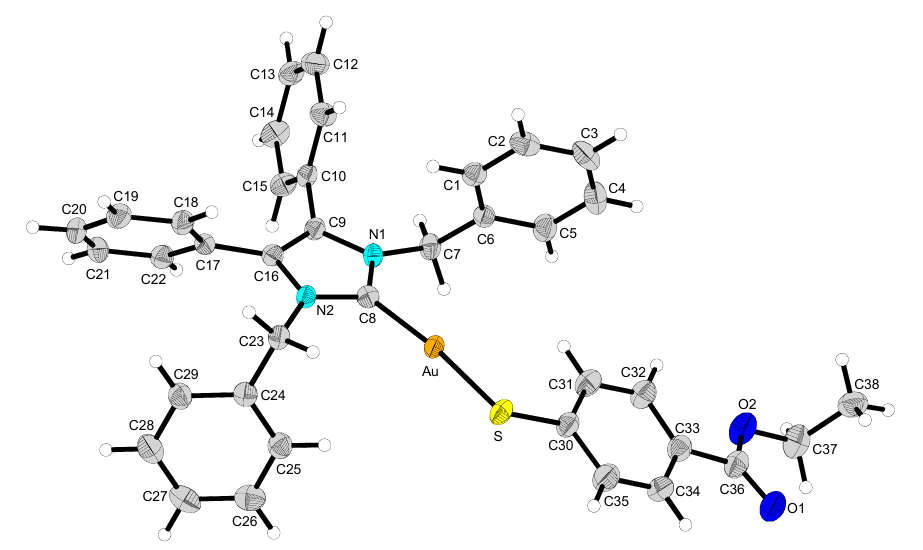
Figure 6. X-ray diffraction structure of 14 ; thermal ellipsoids are drawn on the 50% probability level. Table 1. Crystal data and structure refinement for complexes 2, 12, 13 , and 14.